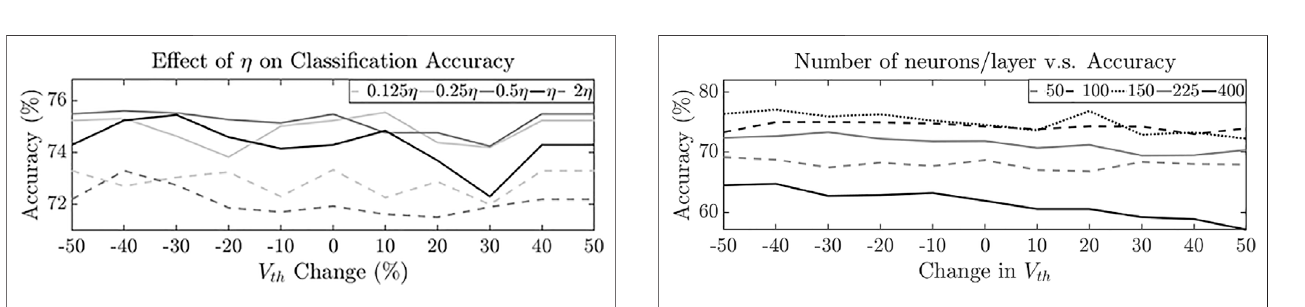
FIGURE 12 | Change in STDP learning curve with (A) learning rate ( η ); and (B) trace decay constant ( τ ).